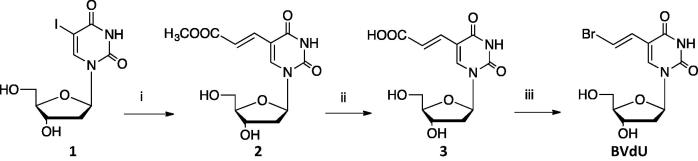
Synthesis of BVdU; Reagents and conditions; i) Pd (OAc)2, PPh3, Me acrylate, ii) NaOH, HCl, iii) NBS, K2CO3.